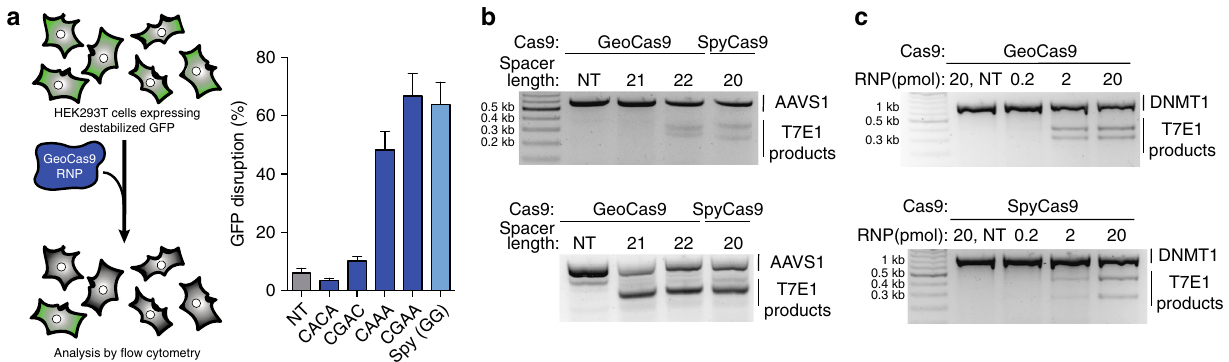
Fig. 4 Genome-editing activity of GeoCas9 in mammalian cells. a EGFP disruption in HEK293T cells by GeoCas9. HEK293FT cells expressing a destabilized GFP were transfected with GeoCas9 RNP preassembled with a targeting or non-targeting guide RNA. Cells were analyzed by fl ow cytometry and targets adjacent to the CRAA PAM resulted in ef fi cient GFP disruption. b T7E1 analysis of indels produced at the AAVS1 locus when the guide length was varied from 21 to 22 nt. The Cas9 used is indicated above each lane and the length of the spacer is shown below. c T7E1 analysis of indels produced using a titration of GeoCas9 and SpyCas9 RNP targeting the DNMT1 locus in HEK293T cells. The Cas9 used is indicated above each lane and the amount of RNP delivered to each well of a 96-well plate is indicated below. NT non-targeting